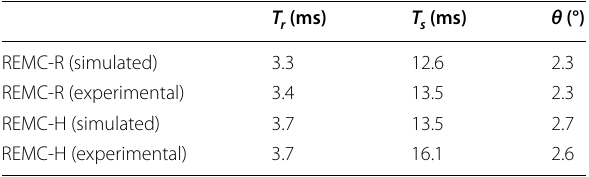
Table 3 Experimental analysis of step